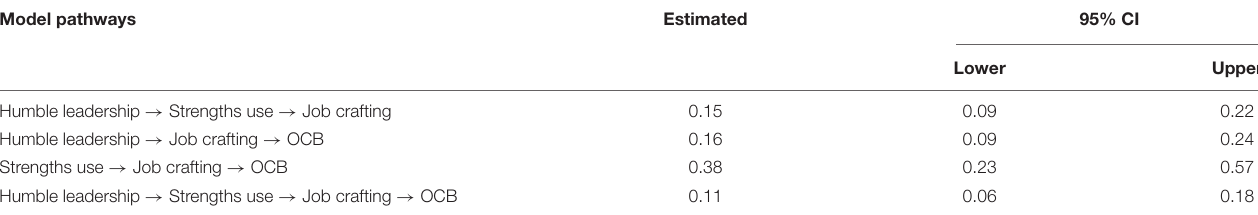
TABLE 4 | Standardized indirect effects and 95% confidence intervals. Model